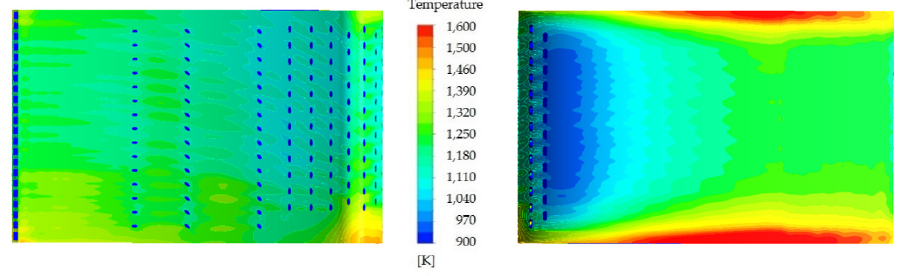
Figure 7. Temperature distribution of vane’s external surface in conventional method.